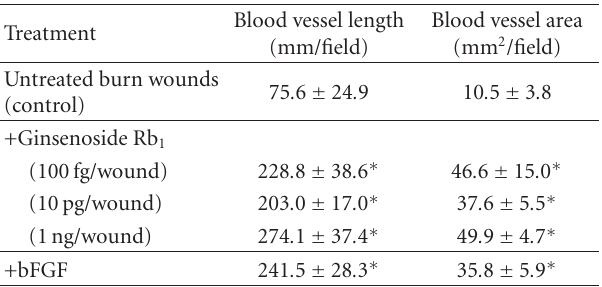
Table 2: E ff ects of ginsenoside Rb 1 on angiogenesis from the area surrounding burn wounds in mice